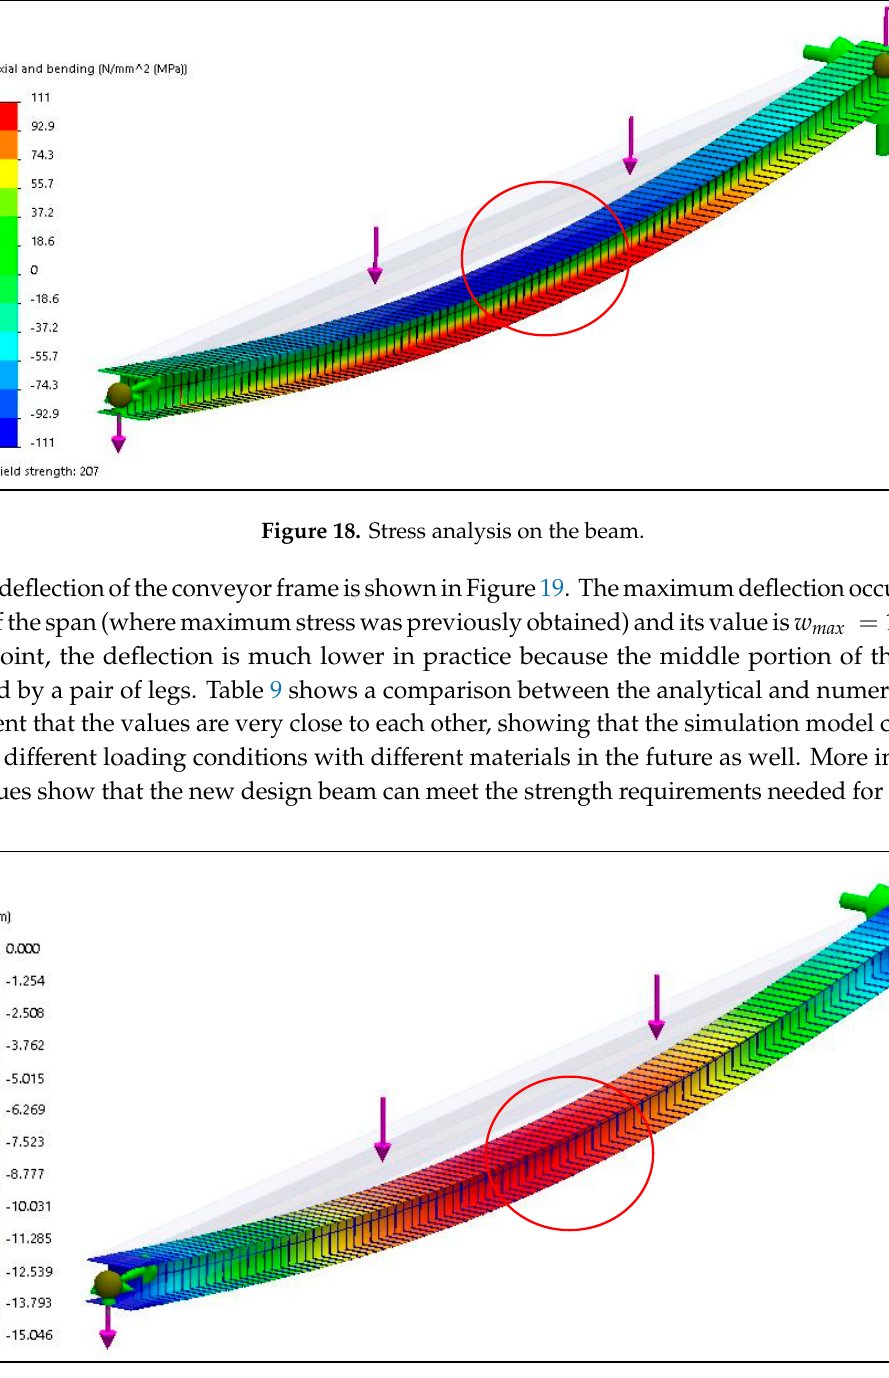
Figure 19. Deflection on the beam. Table 9. Comparison between analytical and simulation results.